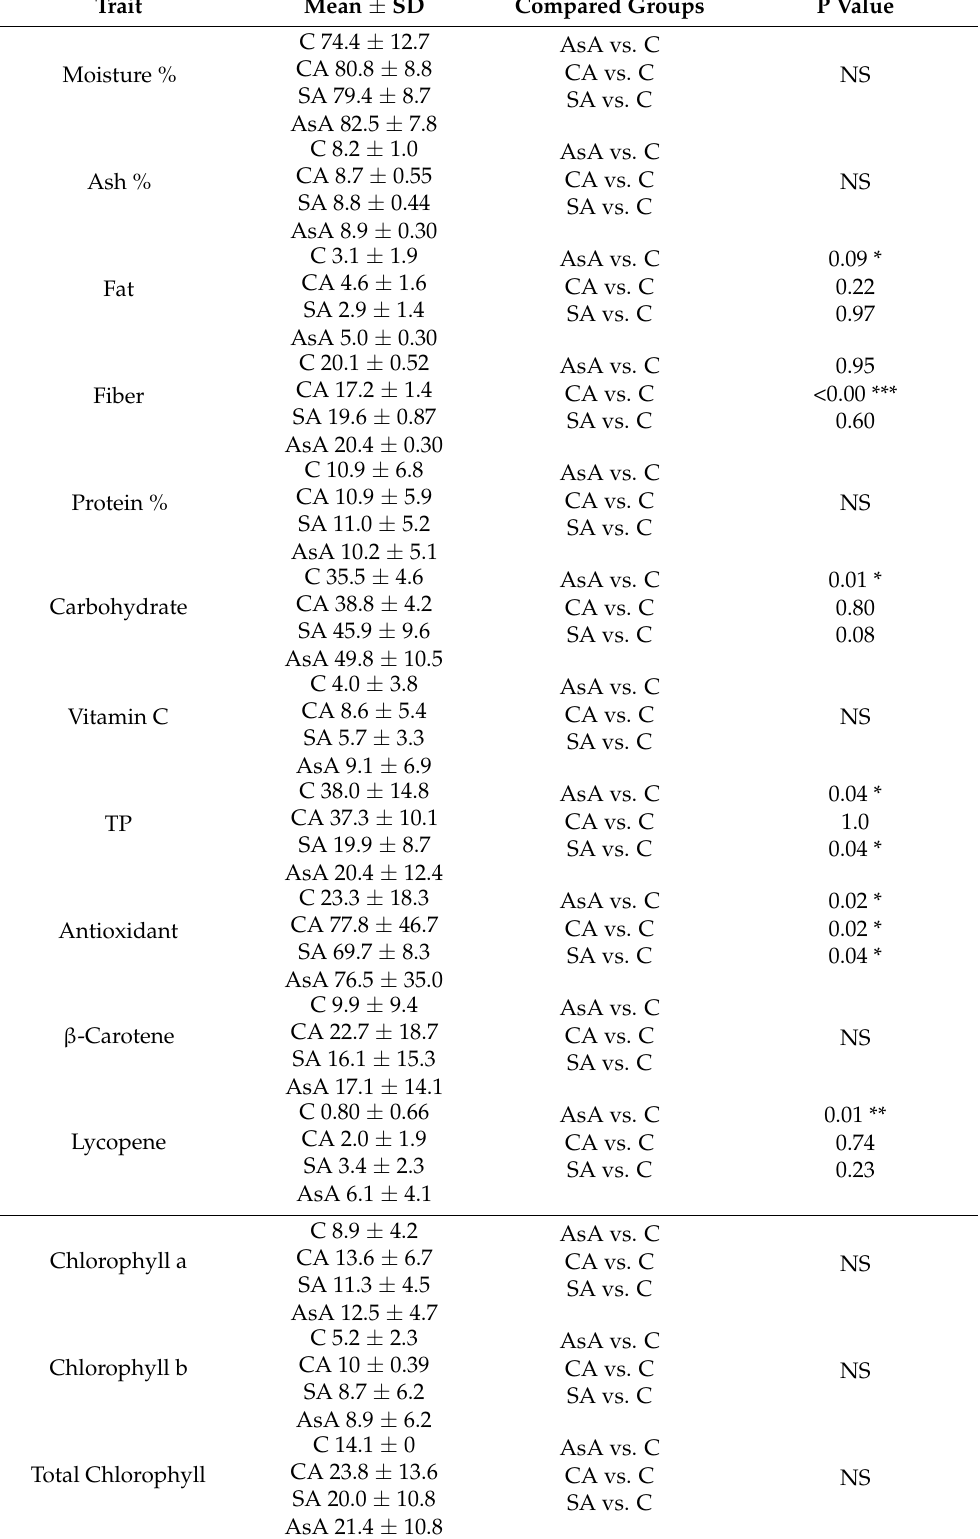
Table 4. Mean ± SD and Dunnett’s test results for nutritional value and biochemical traits of okra pods as a function of